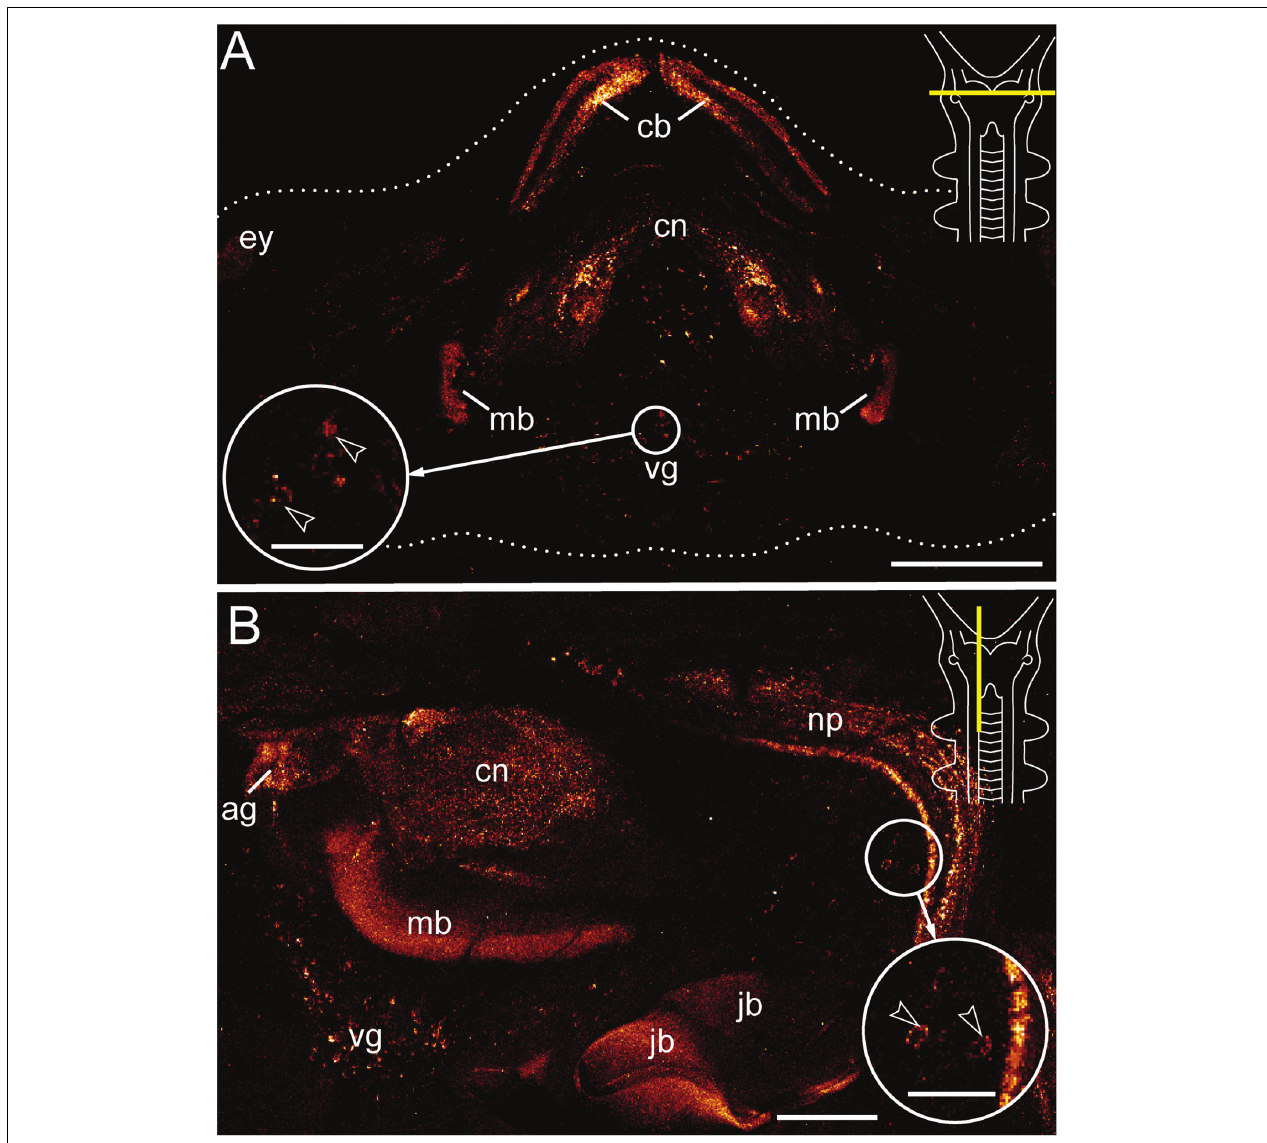
FIGURE 2 | Immunolocalization of arthropsin in the nervous system of the onychophoran Euperipatoides rowelli . Vibratome sections of heads. Confocal micrographs. Dorsal is up in all images. Insets in the upper right corners illustrate sectional plates (yellow bars). (A) Cross section. Note the presence of immunoreactive fibers in the central body, the central neuropil, and the inner lobes of the mushroom body. Note also a ventral group of immunoreactive somata within the protocerebrum (inset, arrowheads). (B) Sagittal section. Immunoreactive fibers are present in the antennal glomeruli of the protocerebrum and the connecting cord that links the ventral nerve cord to the brain. Note also the neuronal somata associated with the connecting cord (inset, arrowheads). The jaw blades (jb) are autofluorescent. Abbreviations: ag, antennal glomeruli; cb, central body; cn, central neuropil; ey, position of the eye; jb, jaw blades; mb, mushroom body; np, neuropil of the connecting cord; vg, ventral group of cells. Scale bars: 250 µ m (A) , 125 µ m (B) , 50 µ m (insets A,B